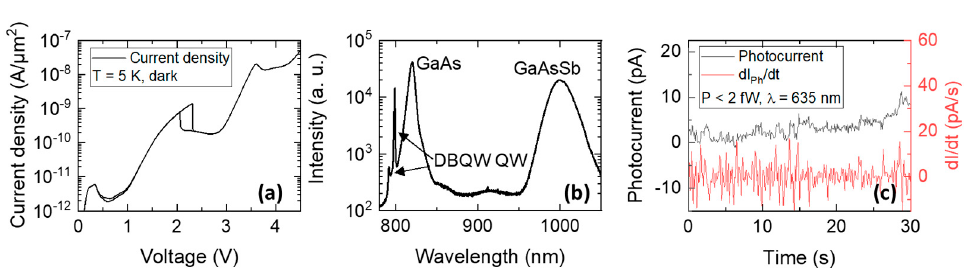
Figure 4. RTD single-photon detector with GaAsSb quantum well as minority charge carrier trap.